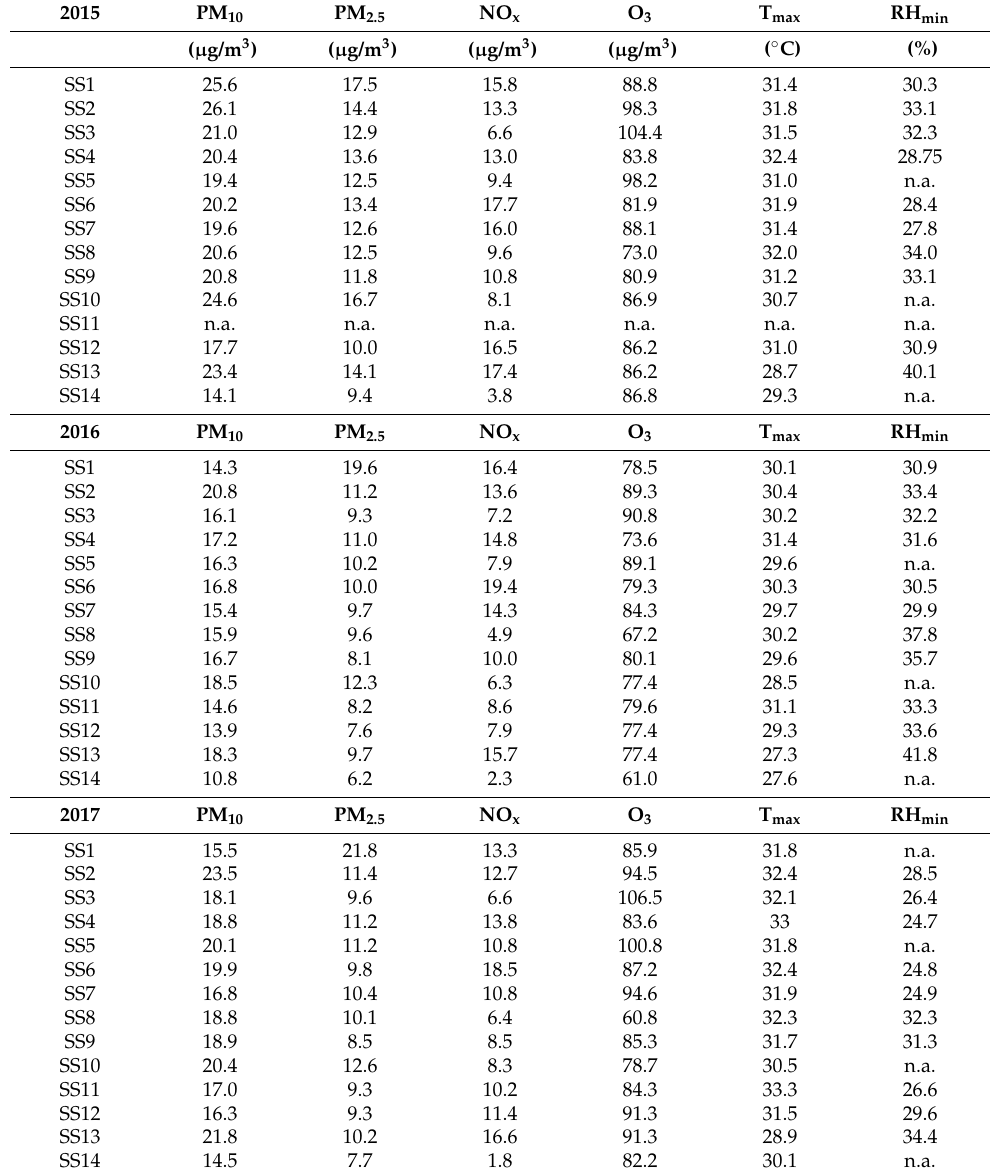
Table 4. Mean values of pollutants concentrations, maximum daily temperature (T max ), and